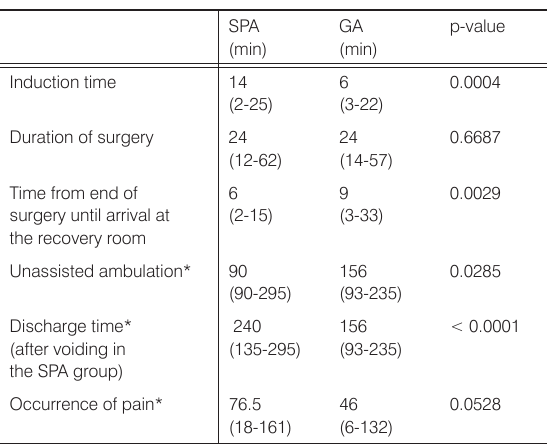
Table 3. Comparison of time spans between spinal (SPA) and general anaesthesia (GA). Time spans marked with an * are measured from the end of induction; median and range are given. Unassisted ambulation: bromage score = 0. Discharge time: 18 points on the modified Aldrete score [ 15 ], complete regression of the spinal block tested clinically by patients´ possibility to get up and walk without assistance and spontaneous micturition in the SPA group.